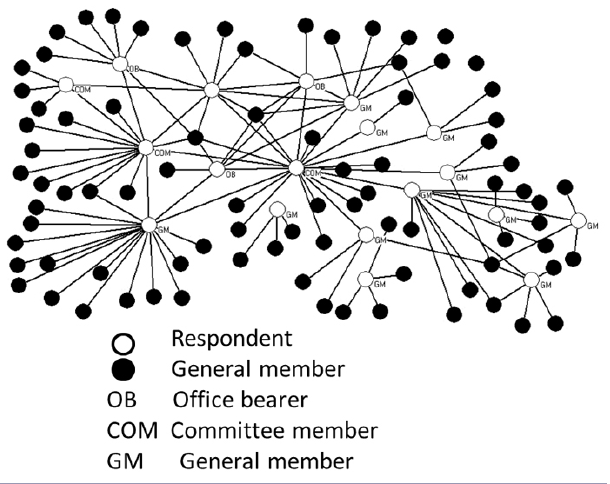
Fig. 4 . Landcare Group B issue-based social network